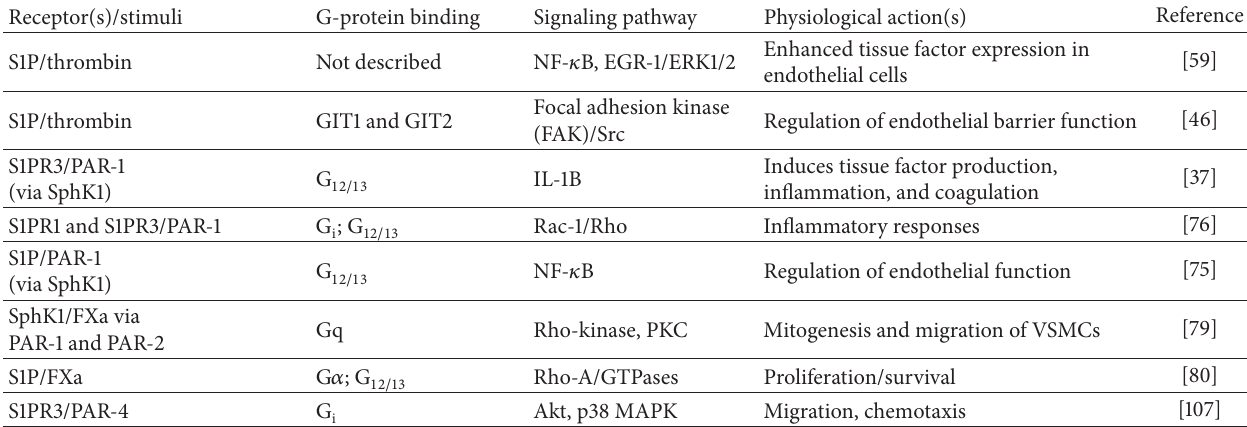
Table 1: Mechanistic studies which directly link S1P and its receptors to the thrombin or FXa receptors PAR-1 to PAR-4, their (patho)physiological actions, and associated signaling